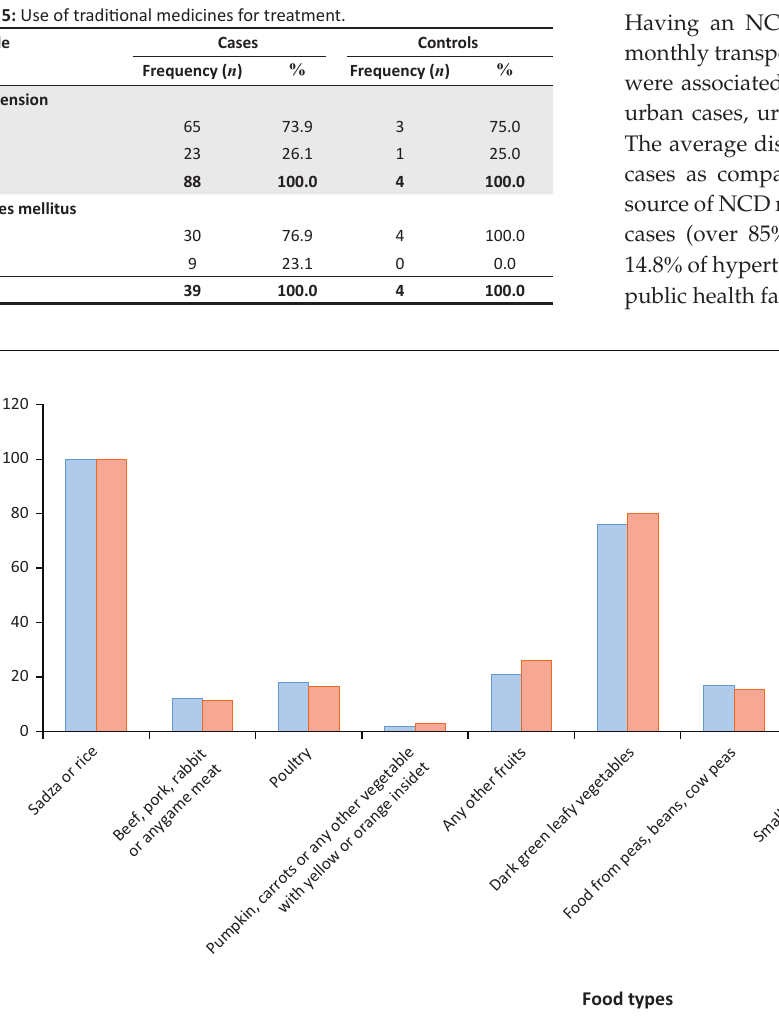
FIGURE 3: Common foods consumed by participants: 24-h food recall.